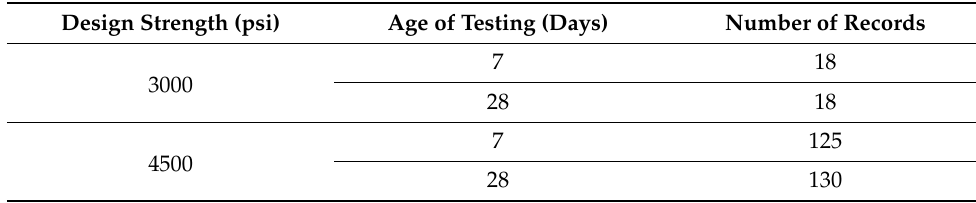
Table 1. Record identifying the strength.